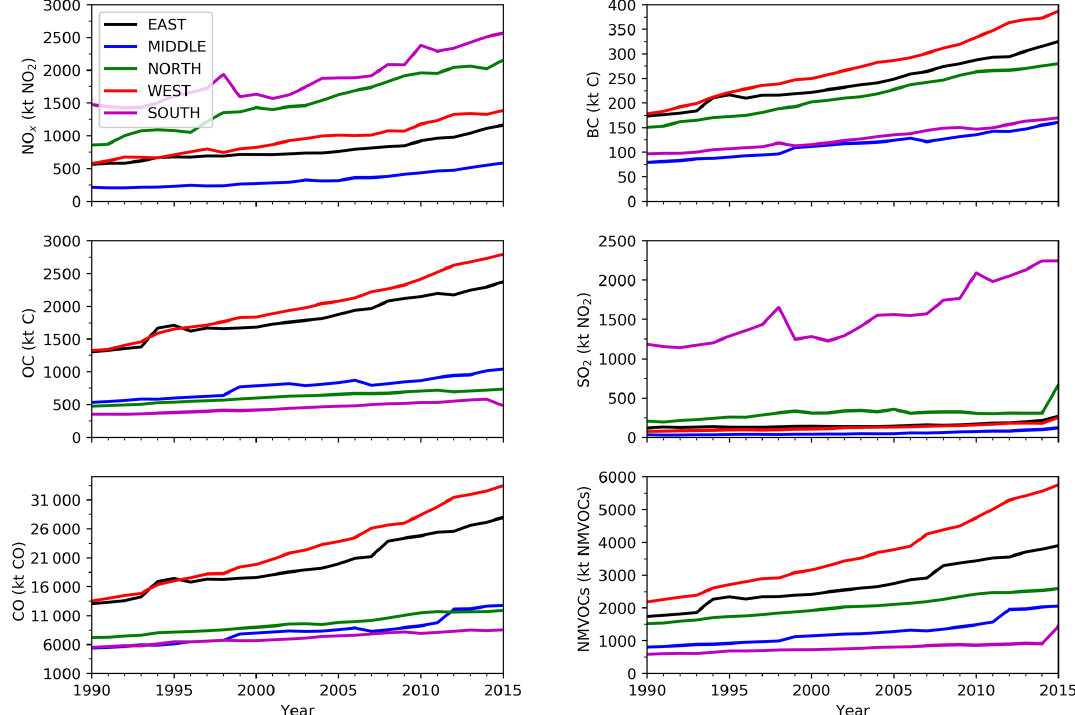
Figure 2. Time series of regional emission estimates of BC, OC, NO x , CO, SO 2 and NMVOCs for fossils fuel, biofuel and waste burning